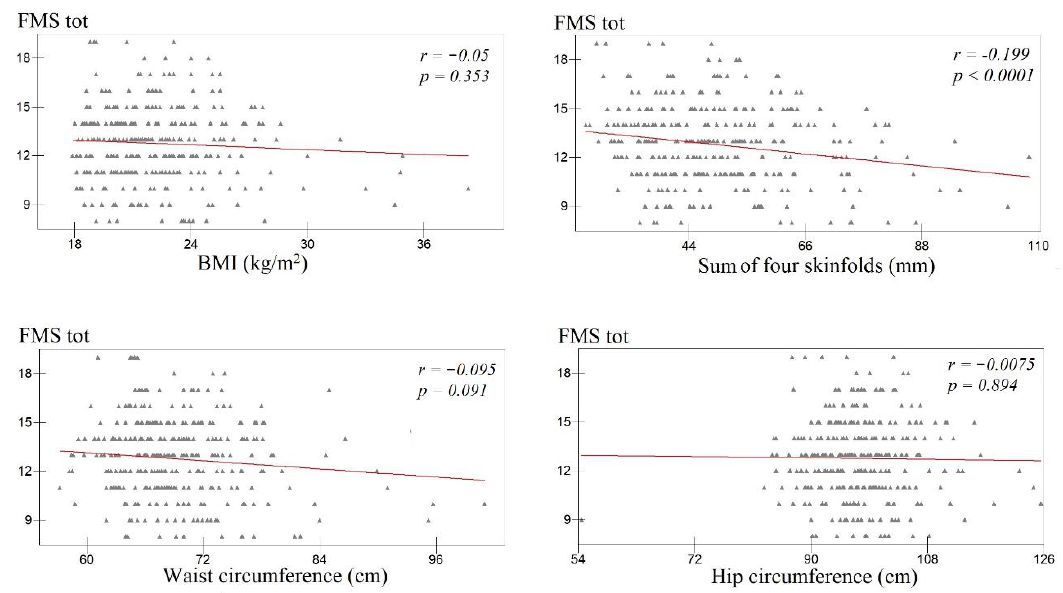
Figure A2. Correlation between BMI, sum of four skinfolds, waist and hip circumference, and total FMS score among girls.